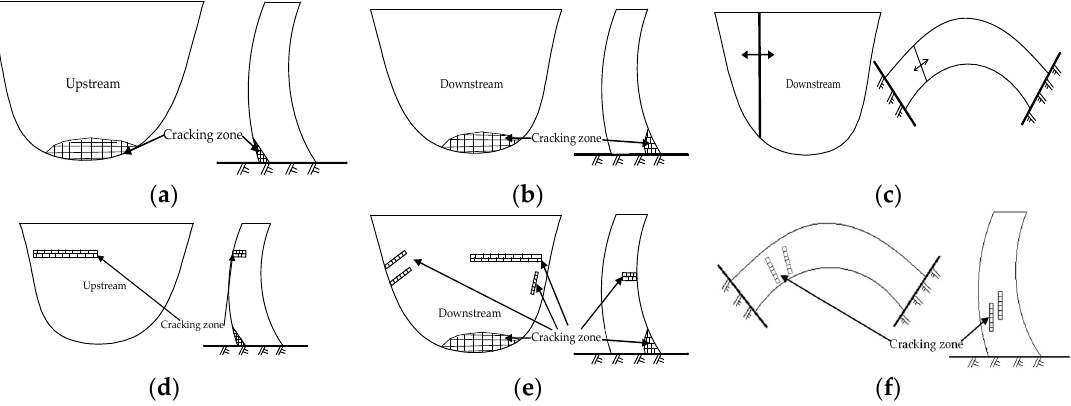
Figure 2. Cracking type of arch dam: ( a ) dam heel crack; ( b ) dam toe crack; ( c ) transverse joint open; ( d ) horizontal cracks at the upstream surface; ( e ) cracks at the downstream surface; ( f ) internal cracks. Table 1. Summary of c racking types in high arch dams.